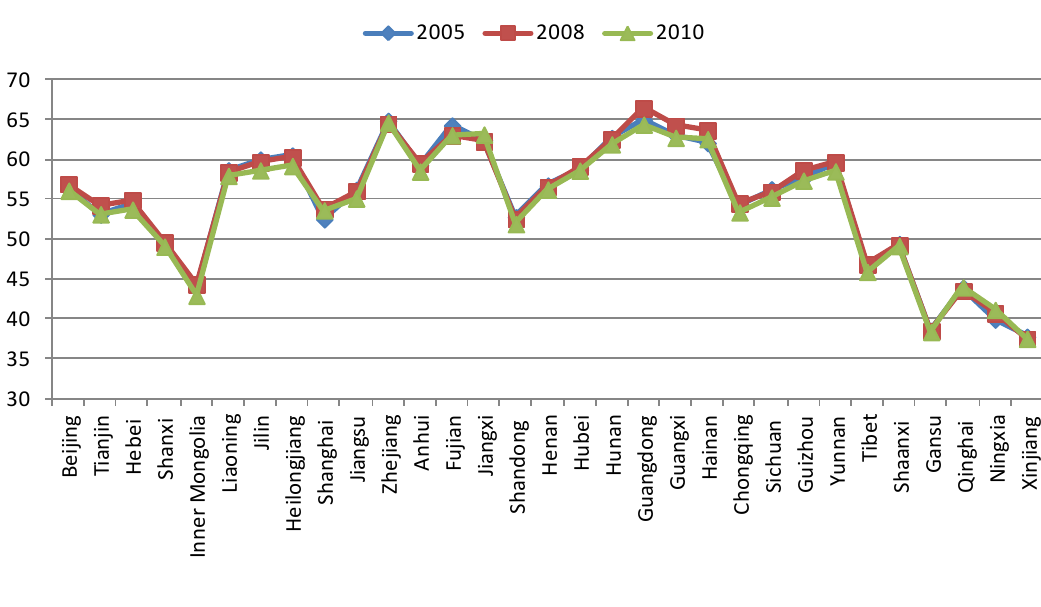
Figure 16. Average provincial EQI in China during 2005, 2008 and